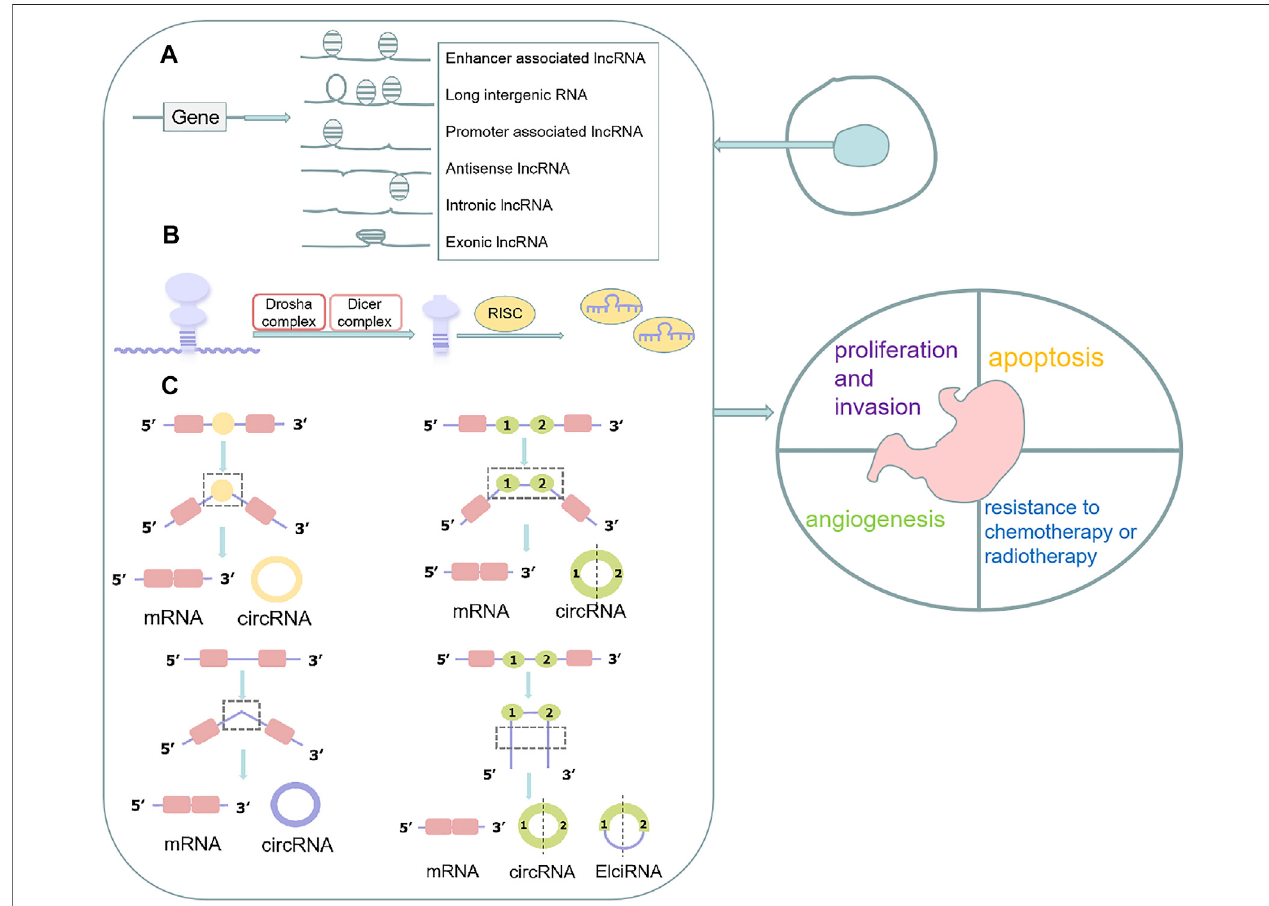
FIGURE 1 | Function, biogenesis and localization of ncRNAs in cells. (A) lncRNAs are classi fi ed into various categories, including promoter-related lncRNAs, enhancer-related lncRNAs, intronic and exonic lncRNAs, antisense lncRNAs, and long intergenic lncRNAs; (B) The pre-miRNAs are loaded into the RNA-induced silencing complex (RISC) where the mature single-stranded miRNA binds to complementary mRNA targets after processed by Drosha complex and Dicer complex; (C) CircRNAs are classi fi ed into different types, including intron circRNAs, exon circRNAs, and extron-intron circRNAs.